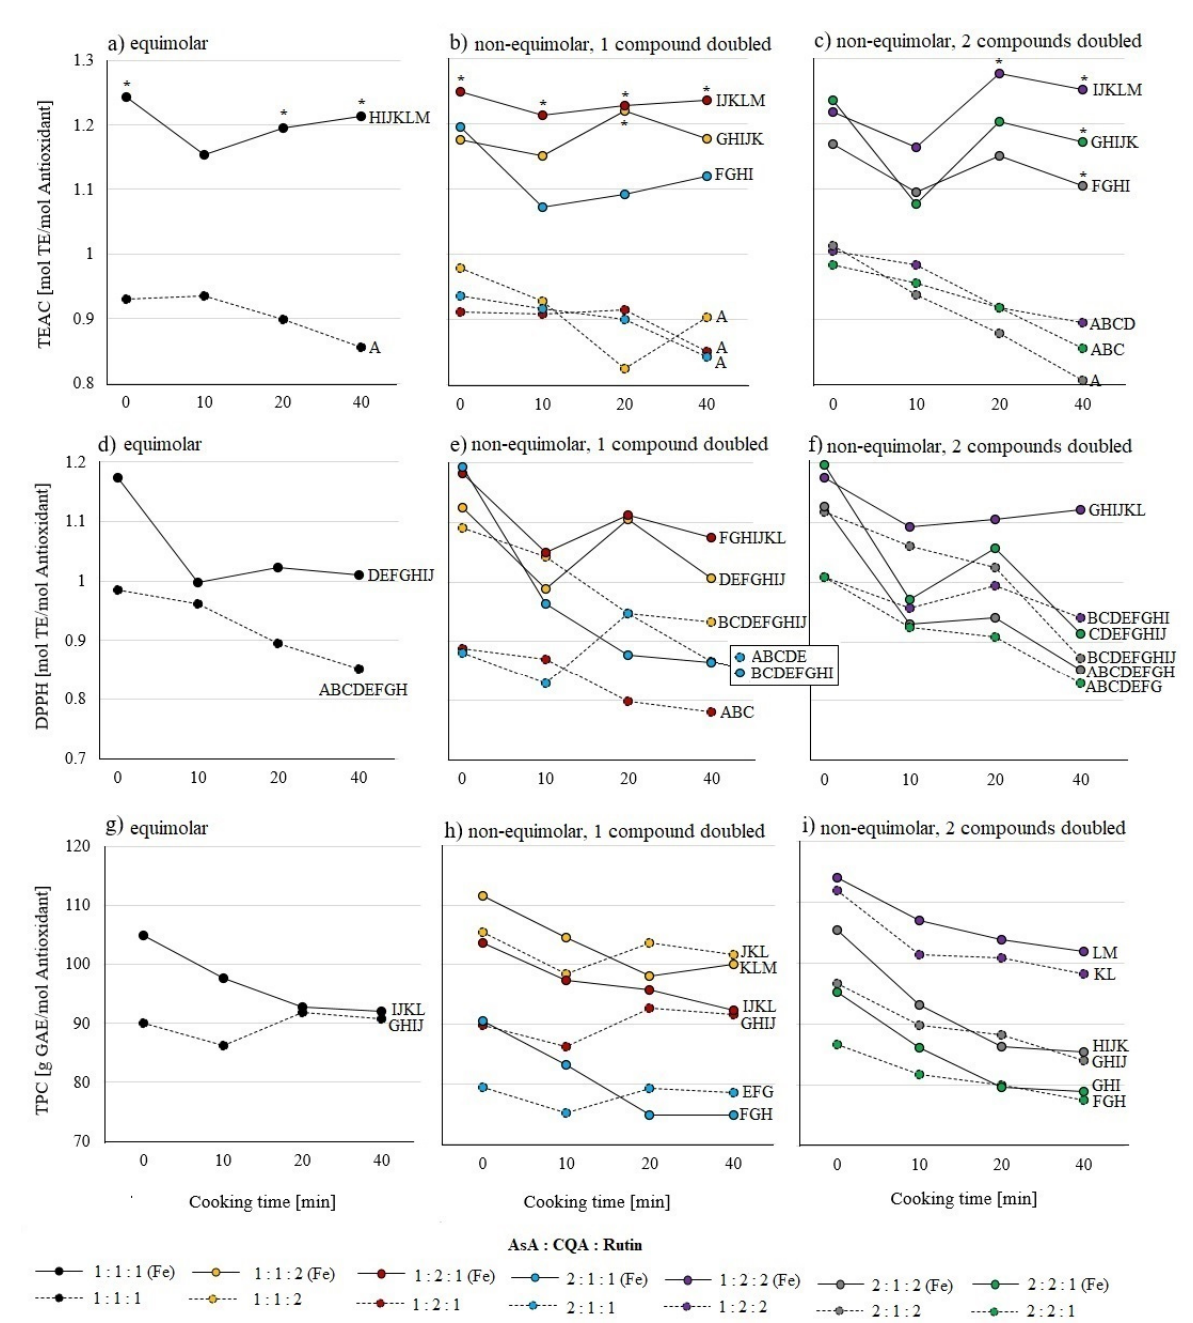
Figure 3. Influence of cooking time (0, 10, 20, and 40 min) on ternary mixtures of ascorbic acid (AsA), 5-caffeoylquinic acid (CQA), quercetin-3-rutinoside (Rutin) with (solid lines) and without (dashed lines) iron (Fe) on AOA; standard deviation not shown. All samples tested using ( a – c ) TEAC, ( d – f ) DPPH, and ( g – i ) TPC assays. Colors indicate different mixing ratios. Significant differences ( p ≤ 0.05 by Tukey’s HSD test ( n = 3)) with different exposure times of the same substance and between samples with and without iron are marked with an asterisk *. Letters indicate differences between substance mixtures and ratios as mean values over all measured times and are comparable to results of the same test assay in Figures 1 and